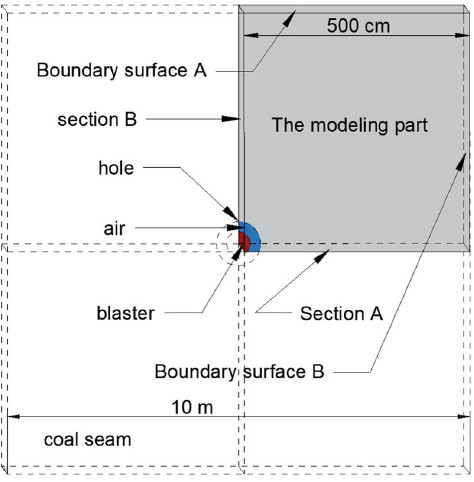
Fig 3. Numerical simulation model of liquid CO 2 blasting in a coal